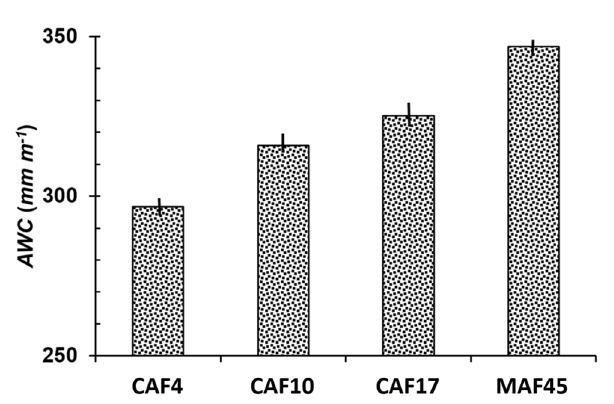
Figure 8. Available water capacity (AWC), expressed as mm of water per meter of soil of young (4–5 yrs.) cocoa agroforestry (CAF4) compared to aging (17 to 34 yrs.) cocoa–based agroforestry, and old (45–68 yrs.) multistrata agroforest (MAF45). Bars are standard errors of the means.